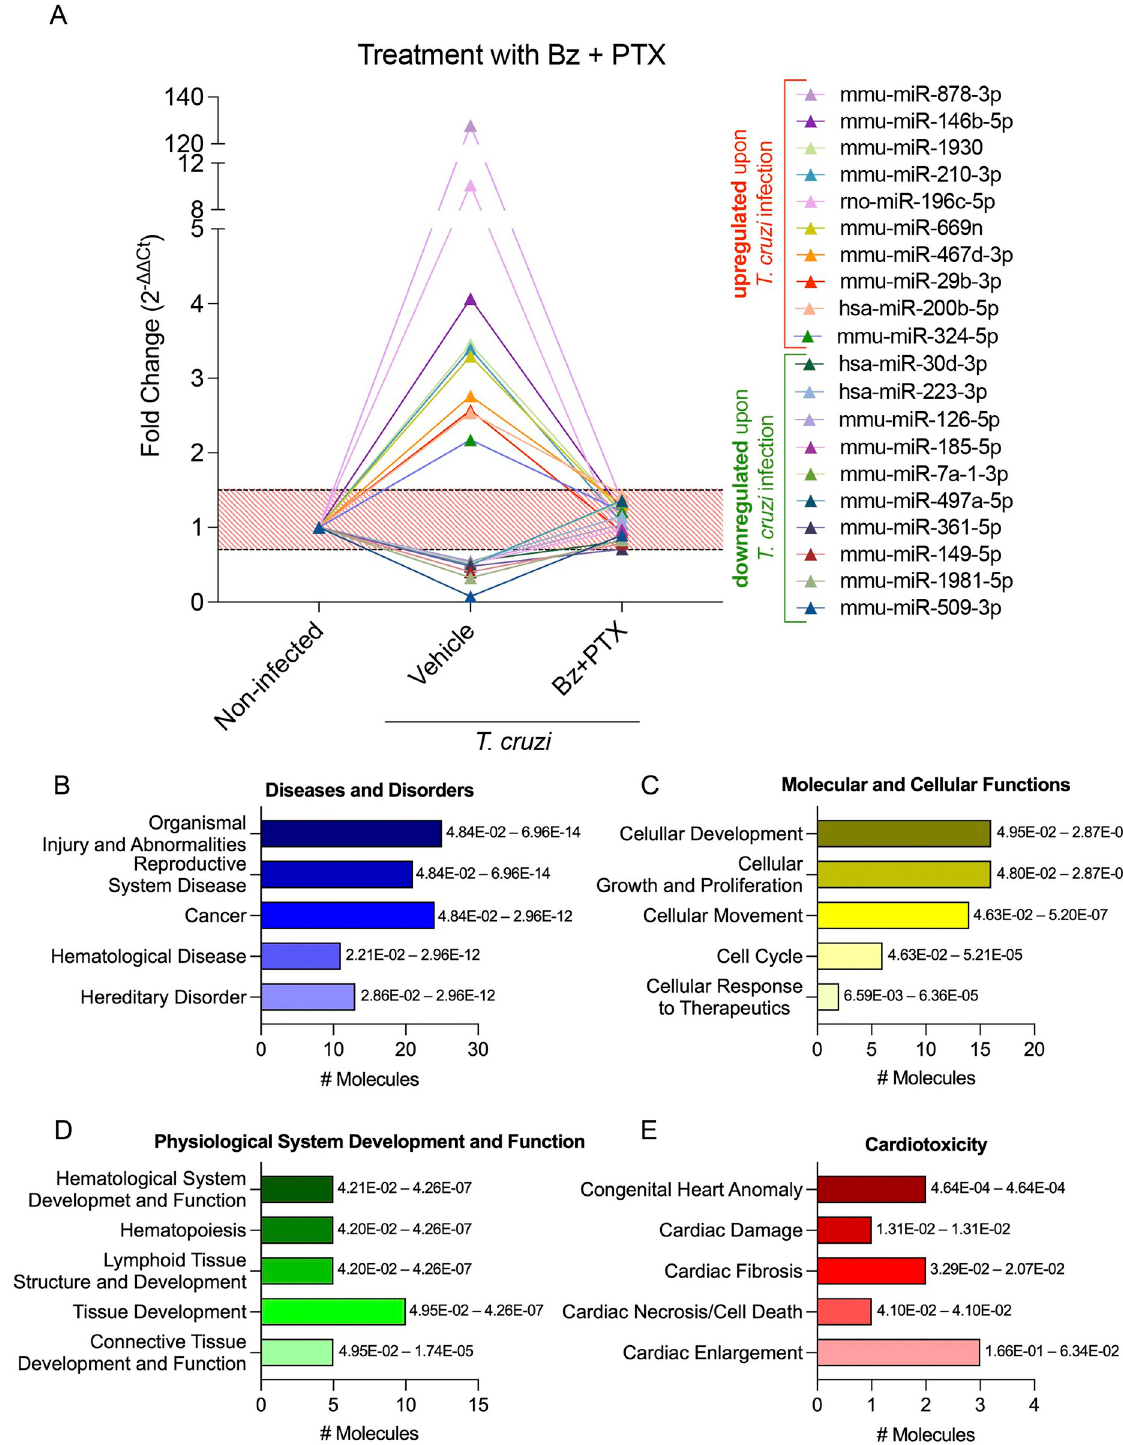
Fig 6. Characterization of immune response expression profile for the Bz+PTX group. (A) Expression of miRNAs altered in the infected group and with restored expression upon Bz+PTX therapy. Relative expression was expressed as fold change (2 - ΔΔ Ct ). miRNAs with a fold change greater than 1.5 in the vehicle group and at the 0.5–1.5 range (red striped area) in the Bz therapy group were considered to have a restored expression. They were selected for further analysis on IPA software. (B-E) Activated pathways in the infected group with a restored expression upon Bz therapy. (B) Diseases and disorders pathway analysis. (C) Molecular and cellular function pathway analysis. (D)